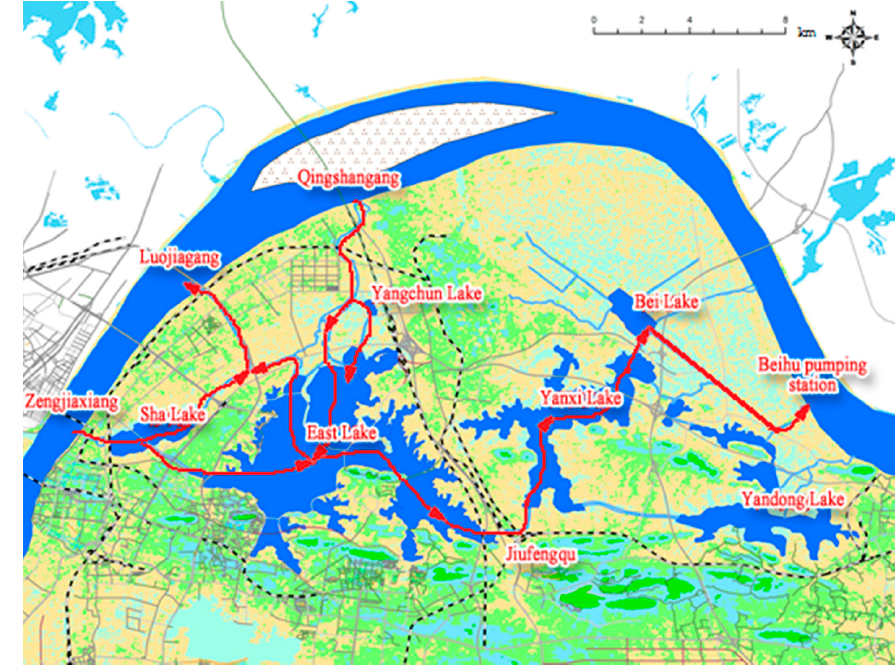
Figure 3. Map of the East Lake